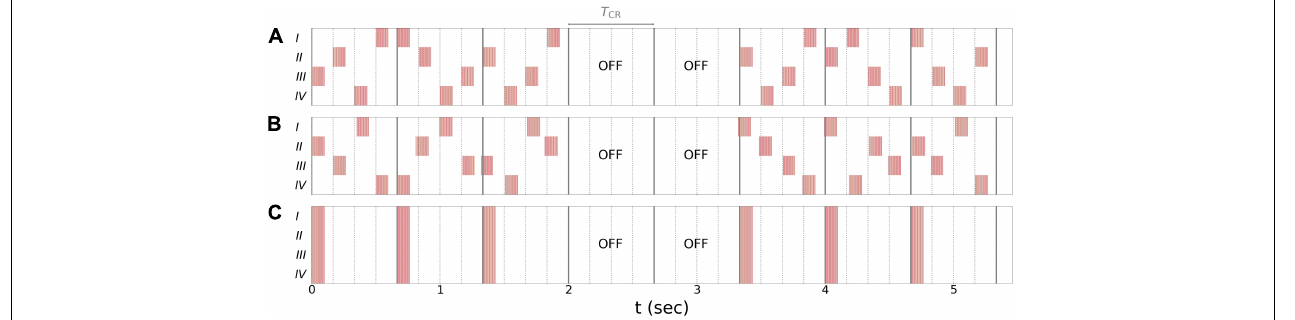
FIGURE 1 | Stimulation patterns used throughout the paper. (A) Regular 3:2 ON-OFF coordinated reset with rapidly varying sequence (CR RVS) pattern. (B) Noisy 3:2 ON-OFF CR RVS pattern and 23.5% jitter. (C) Purely periodic multichannel stimulation. Gray lines indicate multiples of the vibrotactile coordinated reset (vCR) period T CR , and dotted lines indicate multiples of T CR / 4 during individual CR periods. Roman numerals indicate fingertips on one hand. Stimulation bursts are marked red. Red vertical lines indicate maxima of f vib ( t ) , Eq. (2), during individual bursts. Parameters: f CR = 1 . 5 Hz ( T CR 4 = 166 . 7 ms), burst duration 100 ms, and f burst = 250